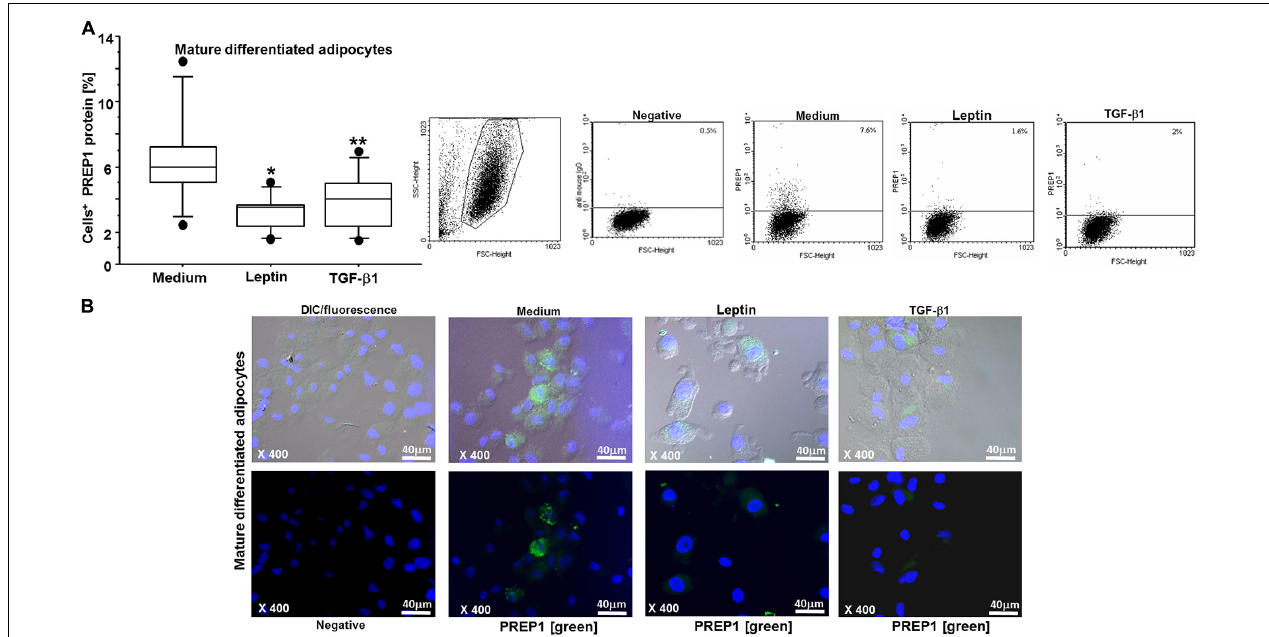
FIGURE 4 | (A) Flow cytometry analysis on mature differentiated adipocytes for PREP1: both leptin (0.05 µ M) and TGF- β 1 (400 nM) significantly reduced PREP1 expression (* p = 0.0138 and ** p = 0.0461, respectively); the results are shown as box-plots with medians (lines inside the boxes), 25th and 75th percentiles (limits of boxes), and the 10th and 90th percentiles (whiskers) ( n = 6 experiments). Analysis of variance (ANOVA), Fisher’s PLSD. Right, representative examples of flow cytometric analysis. The numbers indicate the percentage of positive cells for PREP1. (B) Representative immunofluorescence for PREP1 (green) on mature differentiated adipocytes is shown: higher, differential interference contrast (DIC-Nomarski) combined with DAPI and fluorescence; lower, DAPI with fluorescence (magnification at × 400, scale bar = 40 µ m). Axioskop-2-Zeiss